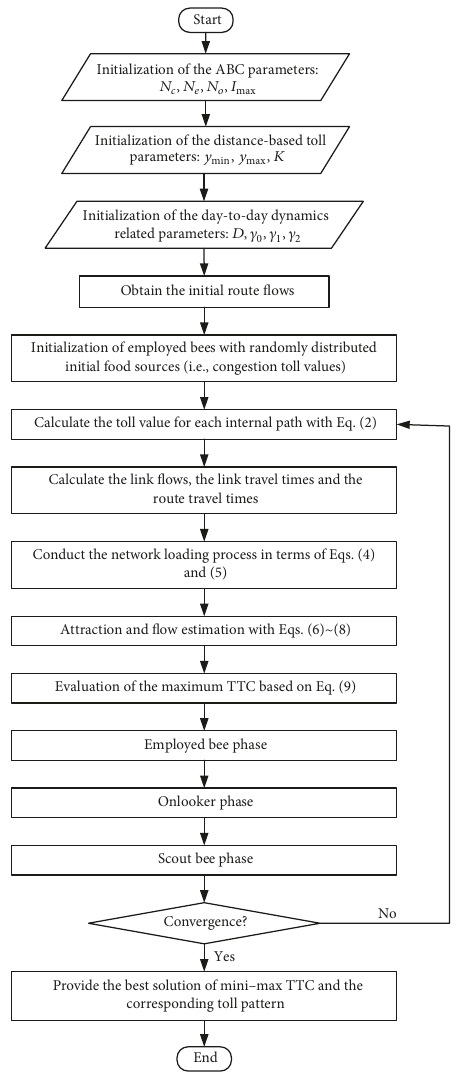
Figure 2: Flowchart of the solution